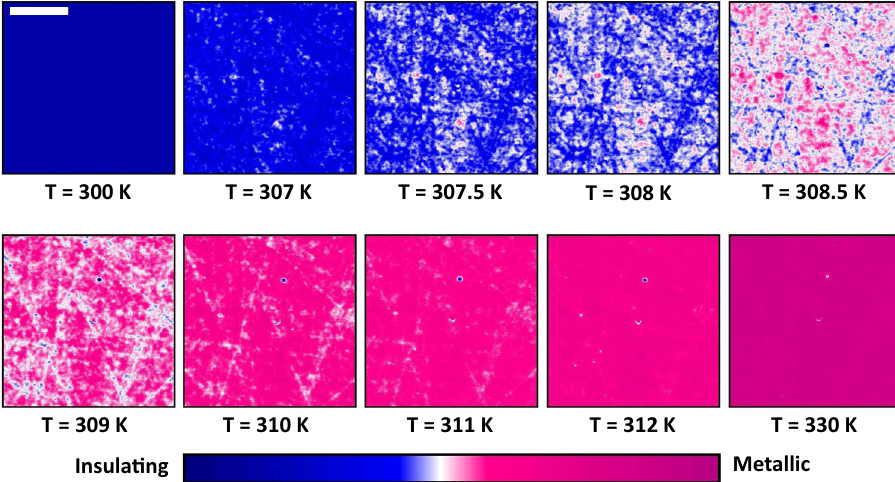
Fig. 5 S-SNIM images of a VO 2 fi lm. S-SNIM images of the 7.2 nm VO 2 fi lm on (001) TiO 2 obtained while heating through the transition. White scale bar represents 2 μ m. The fi lm is in the fully insulating phase (uniform dark blue color) at T = 300 K and fully metallic phase at T = 330 K (uniform dark pink color). There are coexisting insulating and metallic phases at intermediate